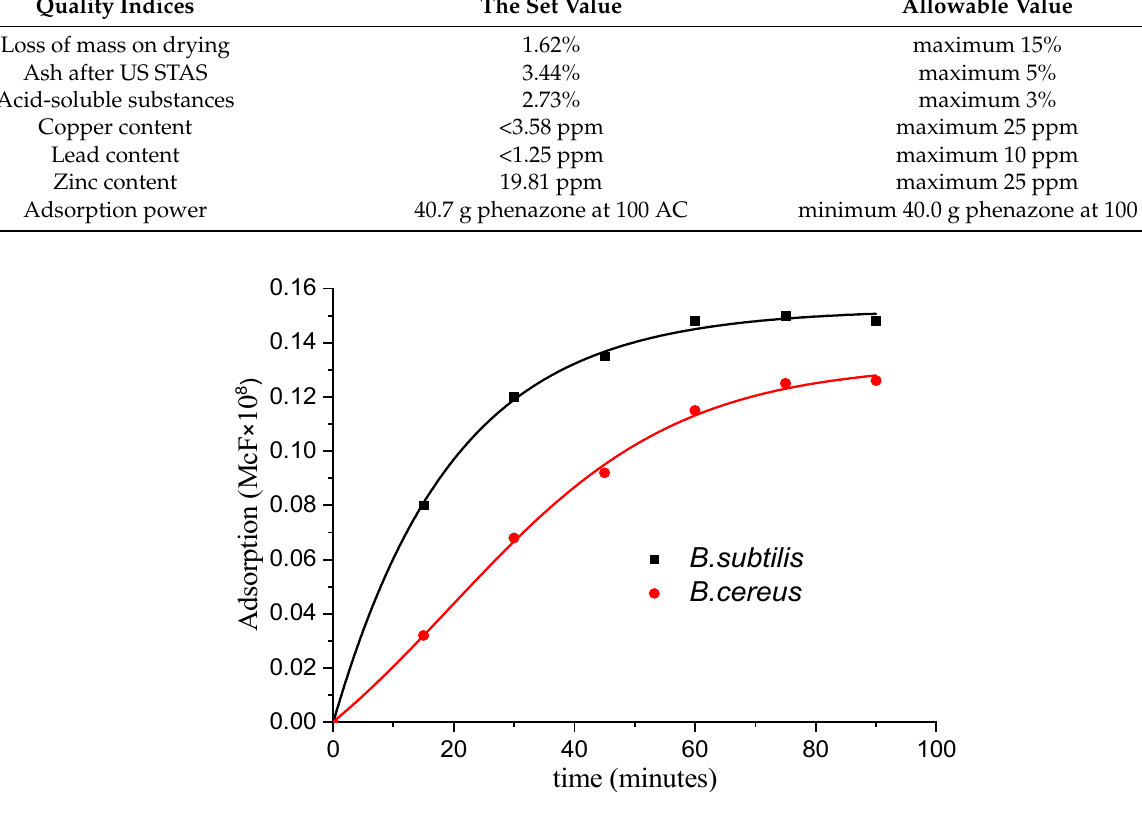
Figure 2. Adsorption kinetics of B. subtilis and B. cereus bacteria on activated carbon AC-C.